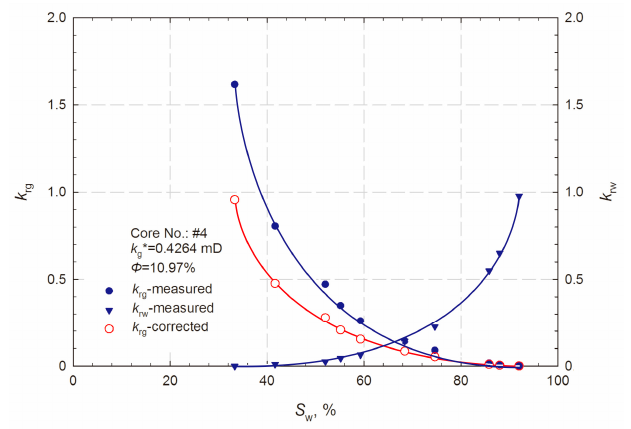
Figure 6. Gas–water relative permeability with and without Klinkenberg correction.